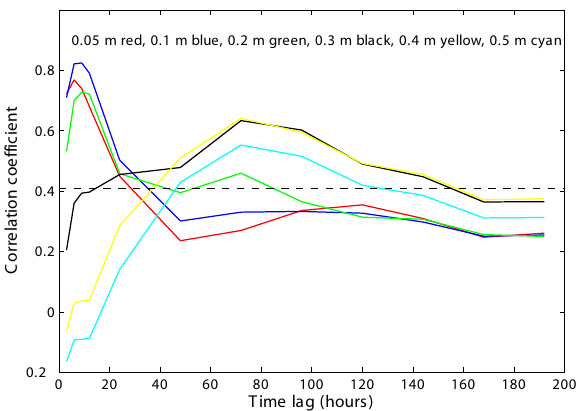
Fig. 5. The correlation coefficient between the air temperature his- tory and the snow temperature in the uppermost 90 cm layer close to Basen nunatak in summer 2006–2007. The dashed line marks the threshold for 95% confidence level.